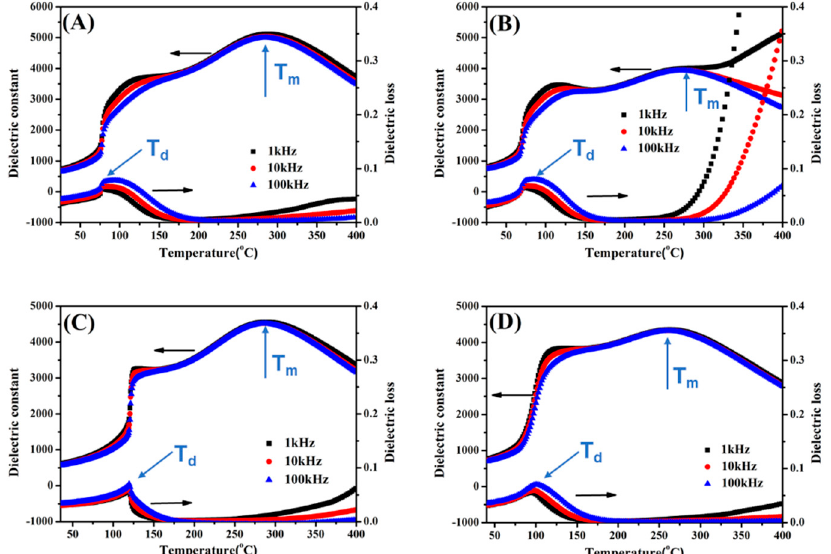
Figure 2. Temperature-dependent of dielectric constant and dielectric loss of ( A ) 88NBT randomly oriented ceramic, ( B ) 88NBT textured ceramic, ( C ) 90NBT randomly oriented ceramic, and ( D ) 90NBT textured ceramic.